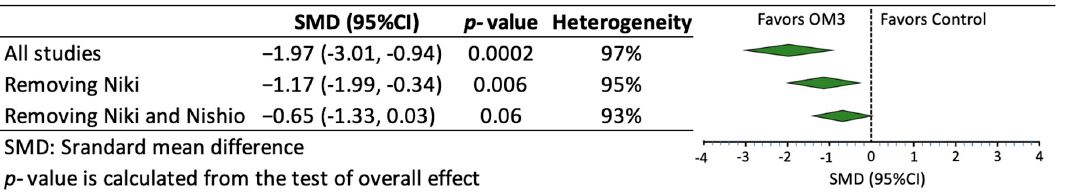
Figure 2. Effect of high-dose marine omega-3 fatty acids on atherosclerosis.